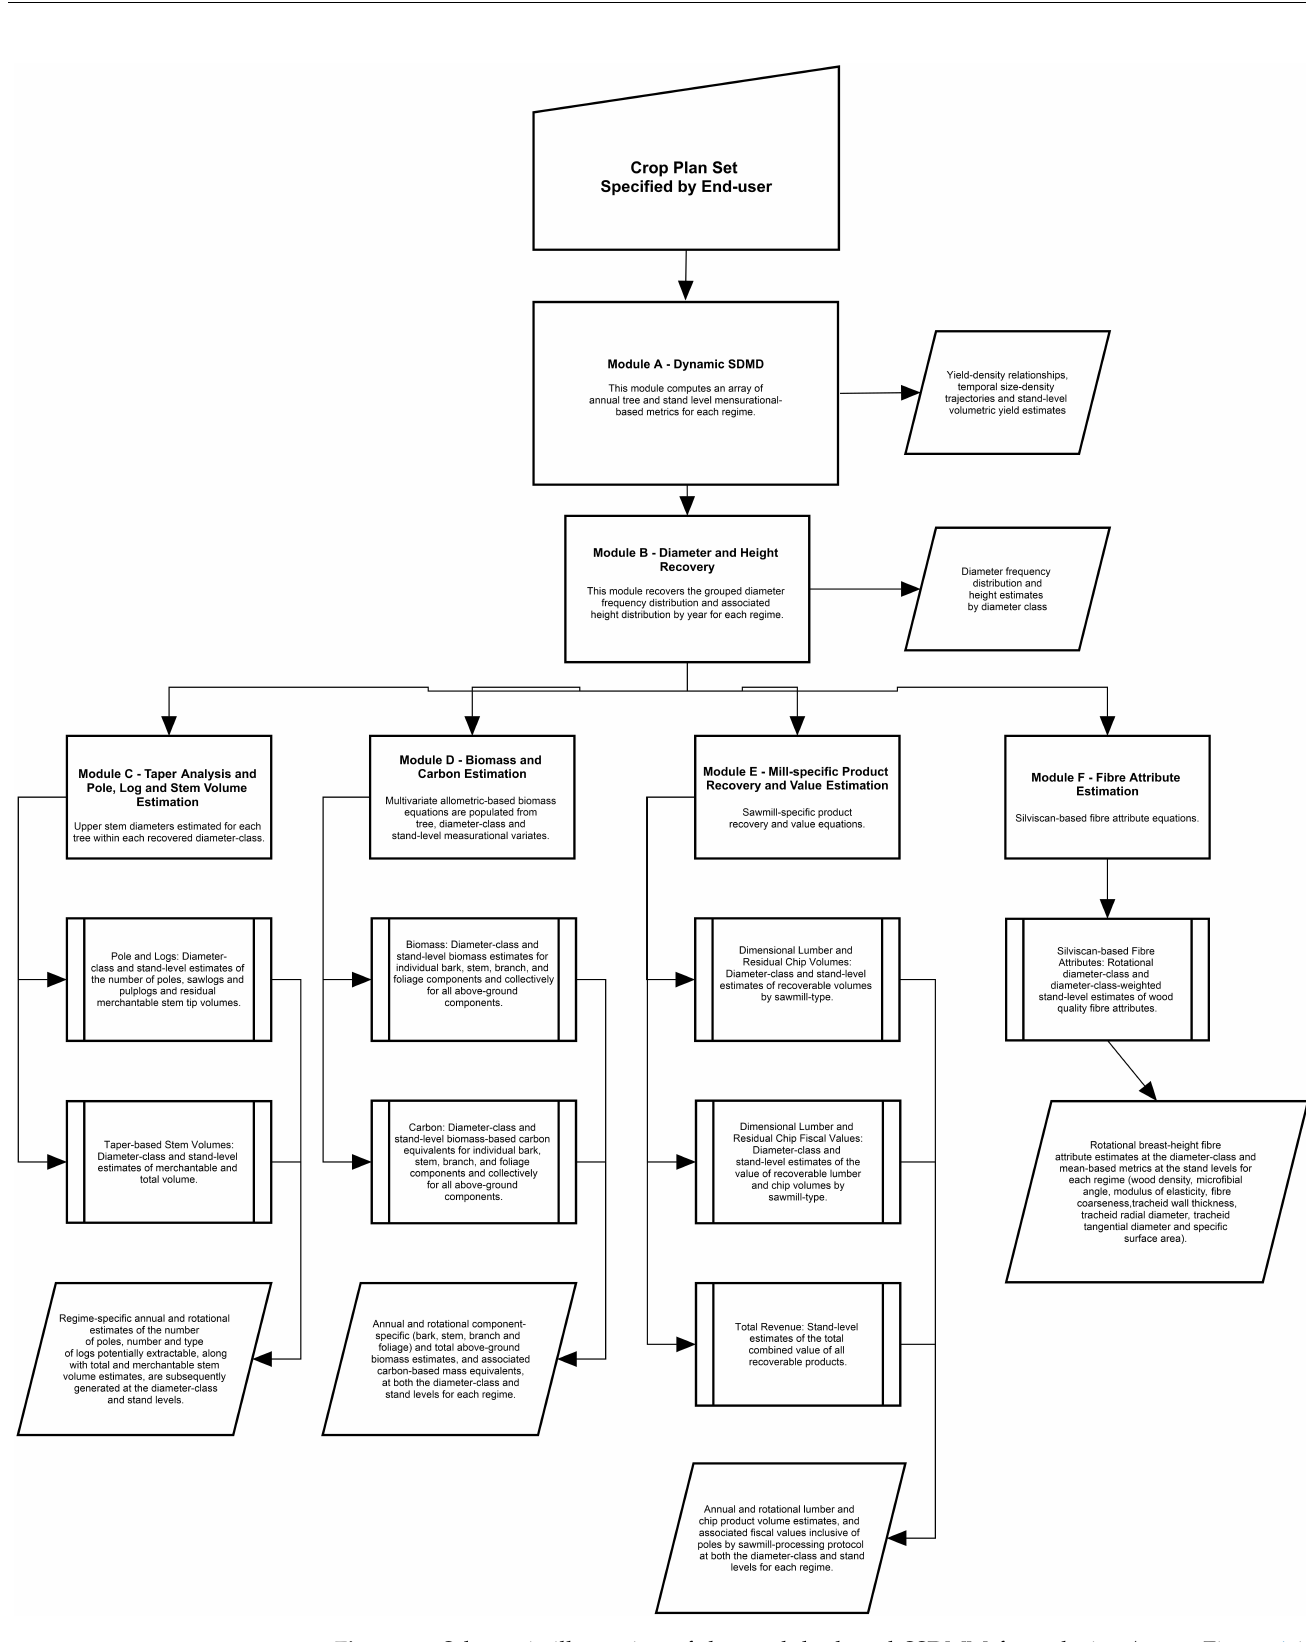
Figure 1. Schematic illustration of the modular-based SSDMM for red pine (sensu Figure 1 in Newton [17]): hierarchical structure and computational